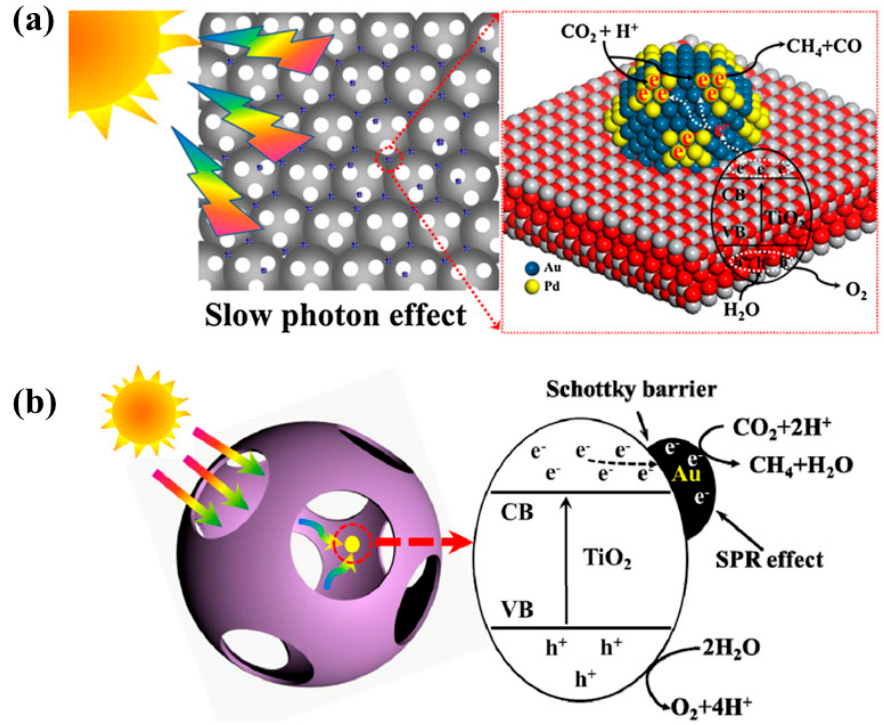
Figure 14. Proposed mechanism of photocatalytic CO 2 conversion with water vapors employing ( a ) AuPd-3DOM TiO 2 photocatalyst (taken with permission from [77]), and ( b ) Au-3DOM TiO 2 photocatalyst (taken with permission from [78]).